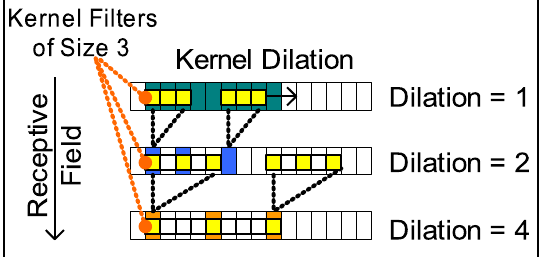
Figure 12. Dilation of kernel filters increases the receptive field of the higher subsequent convolution